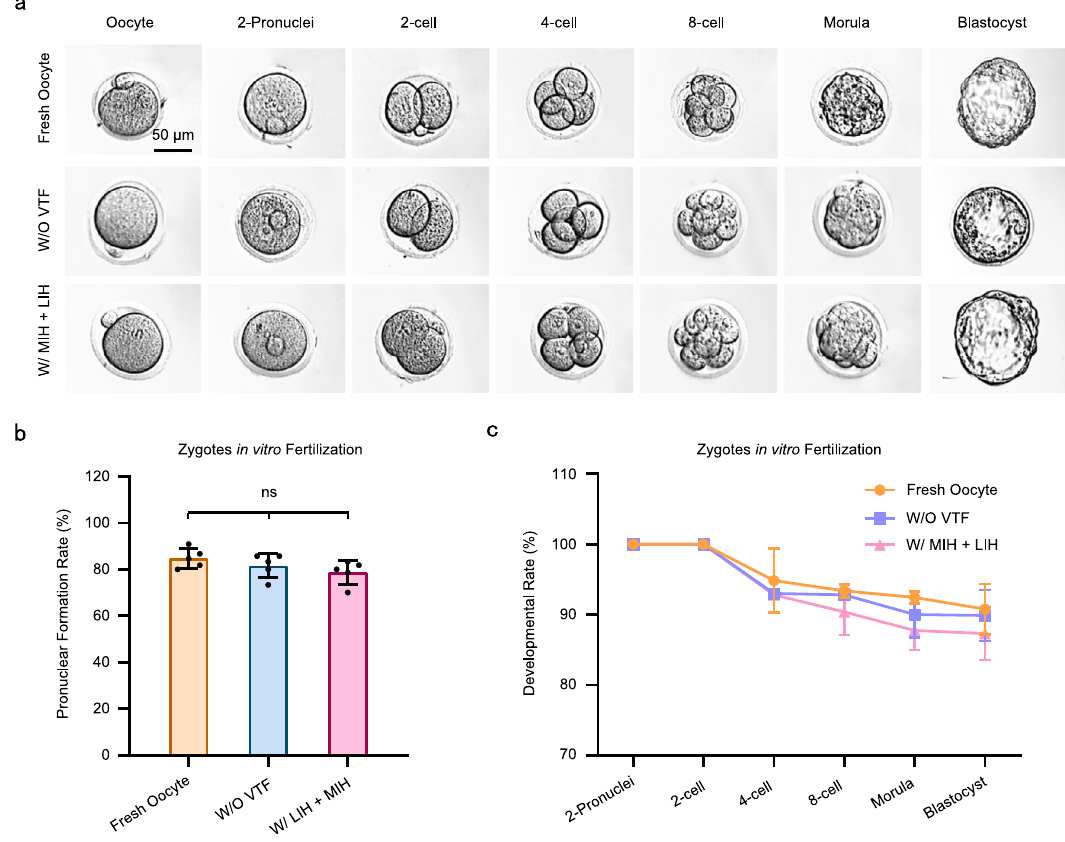
Fig. 5 | IVF ofMII oocytes and development ofzygotes. a Representative images of the development of oocytes in vitro (from MII oocytes to the blastocyst stage). Each experiment was repeated three times with similar results, and representative imagesareshown. b IVFanalysisofoocytes.Pronuclearformationrate:Percentage of 2-pronuclei to total number of oocytes involved in IVF. c Evaluation of the embryonicdevelopmentalperformance. W/OVTF:PAFswereonly encapsulated in hydrogel and did not undergo vitri fi cation; W/ MIH+LIH: PAFs encapsulated in